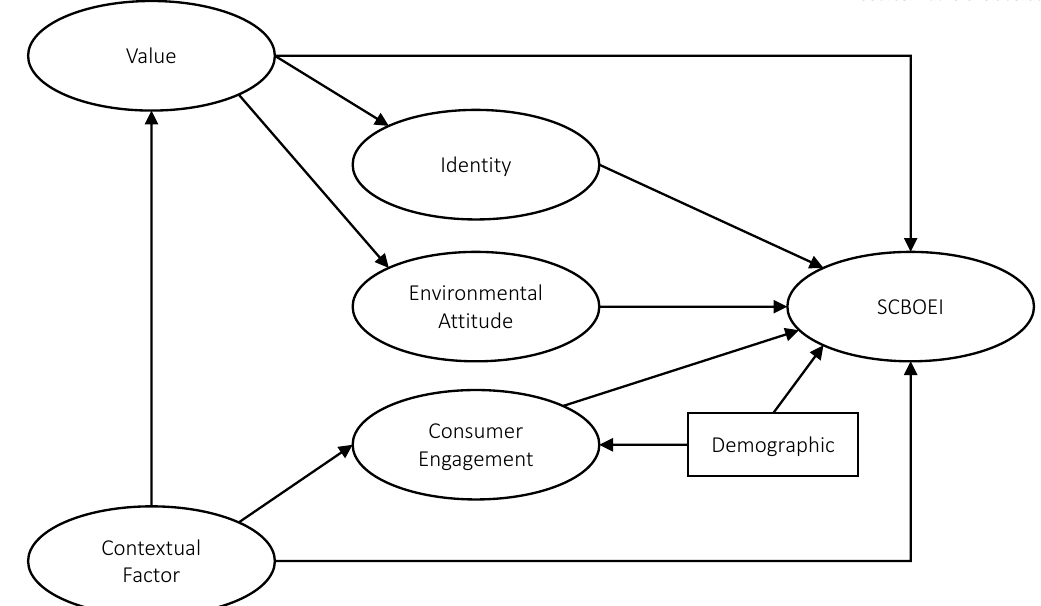
Figure 1. Conceptualized SCBOEI